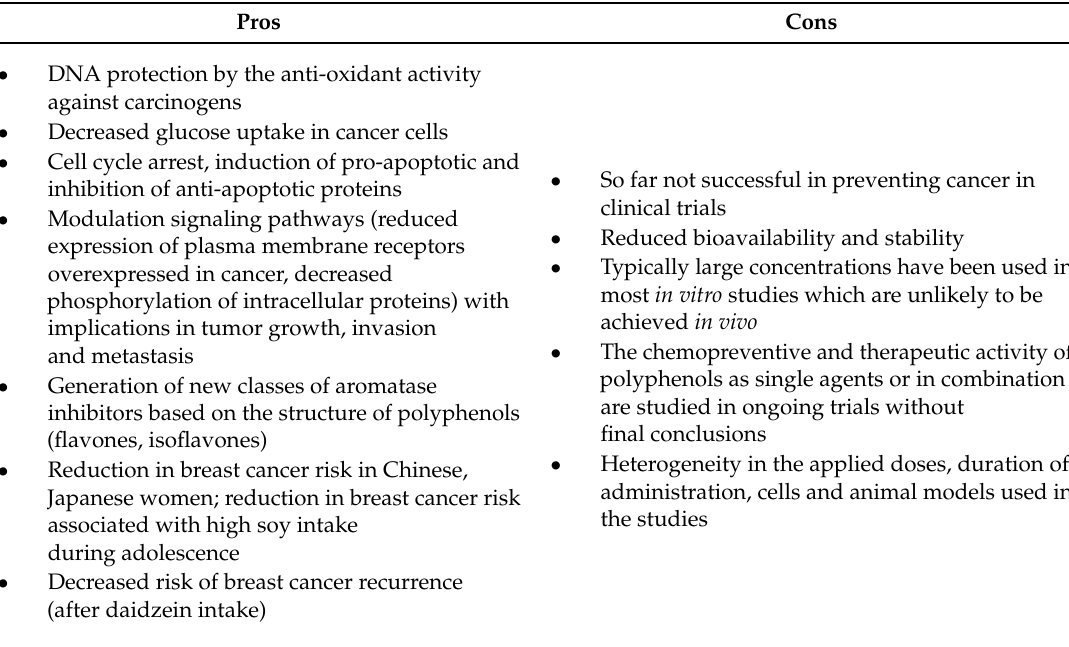
Table 6. Breast cancer: the pros and cons of